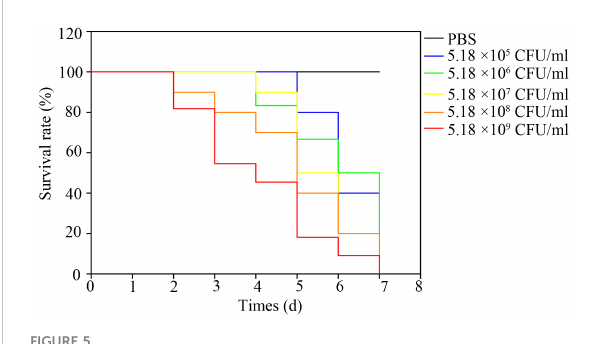
FIGURE 5 Kaplan-Meier survival curves of bullfrogs infected with different doses of NFEM01. Control group/phosphate-buffered-saline (PBS), the concentrations in the infection group were 5.18 × 10 4 , 5.18 × 10 5 , 5.18 × 10 6 , 5.18 × 10 7 , 5.18 × 10 8 , 5.18 × 10 9 CFU·mL -1